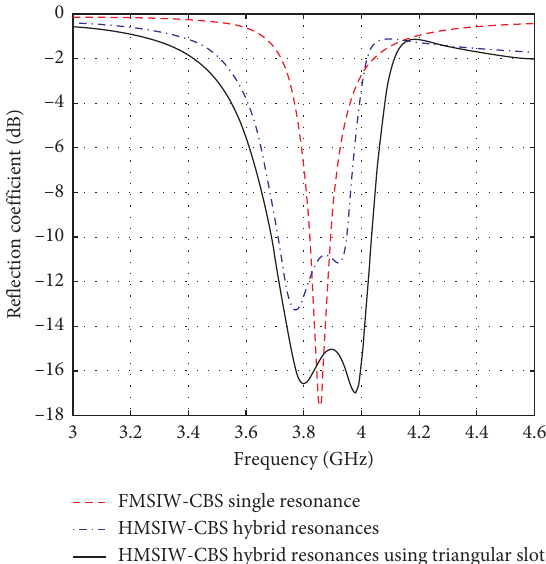
Figure 3: Reflection coefficient for antenna evolution.